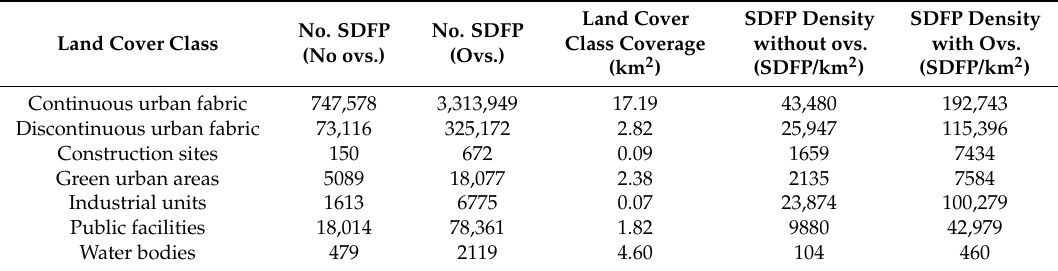
Table 1. Number and density of SDFP observed over 7 land cover